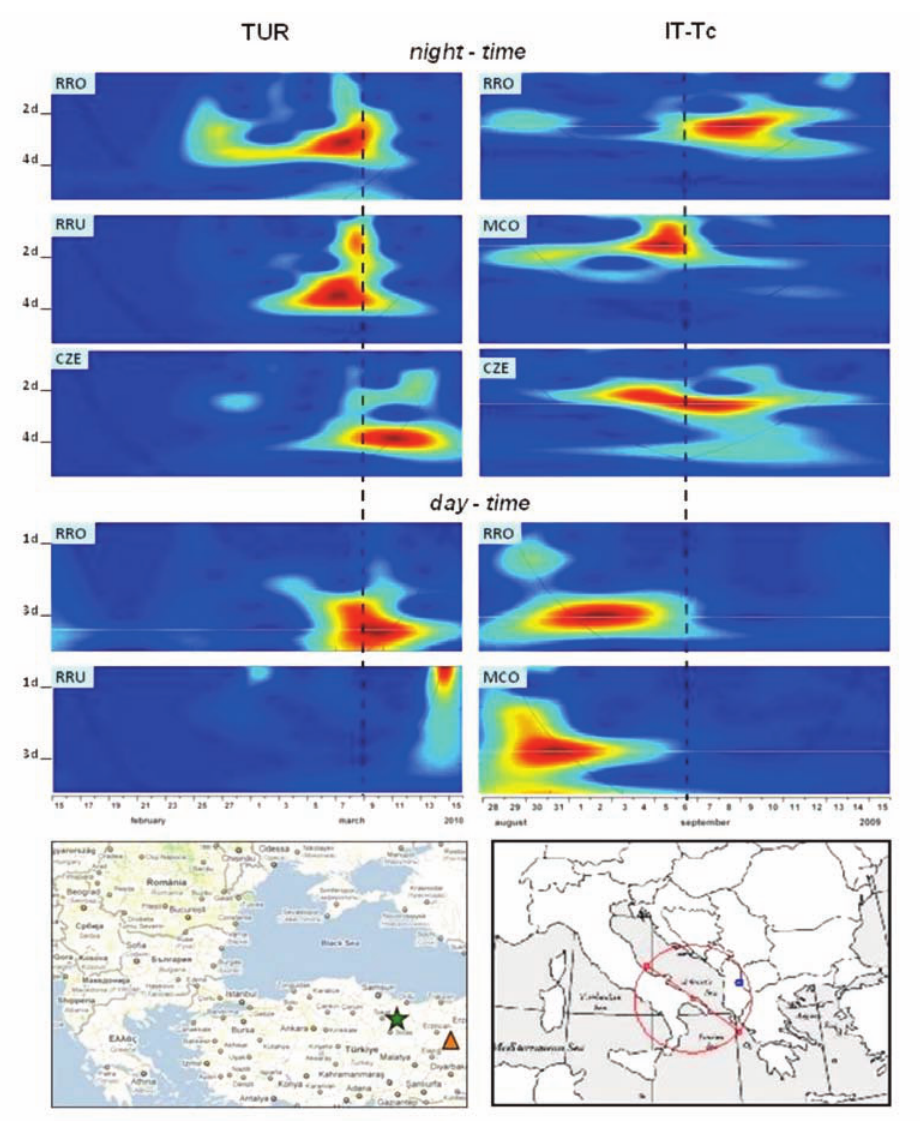
Figure 7. Night-time and day-time spectrograms of some of the radio signals collected by the TUR receiver relative to the M = 6.0 earthquake that occurred on March 8, 2010 (left), and by the IT-Tc receiver relative to the M = 5.6 earthquake that occurred on September 06, 2009 (right). Top panels: Spectrograms of the night-time data. Centre panels: Spectrograms of the day-time data. Continuous black lines, delimitation of the region (COI) of the wavelet spectra in which edge effects become important [Torrence and Compo 1998]. Bottom panels: Maps showing the TUR receiver (star) and the March 8, 2010, earthquake epicenter (triangle) (left), and the epicenter of the September 06, 2009, earthquake that occurred inside the 300-km radius circle around the IT-Tc receiver (right). Vertical dashed lines, times of occurrence of these